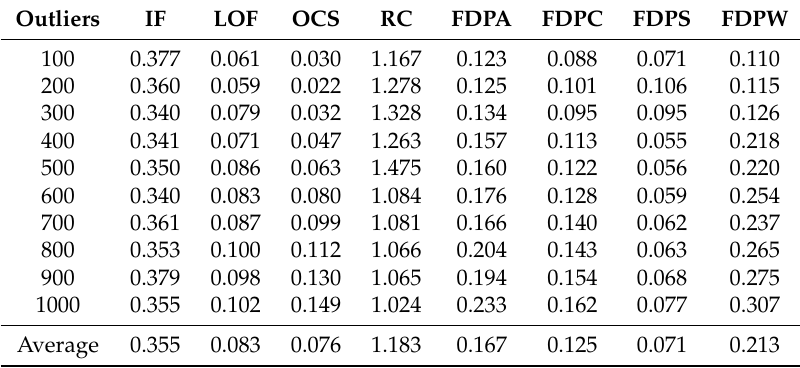
Table 7. The time cost (in seconds) of real-world datasets used in the